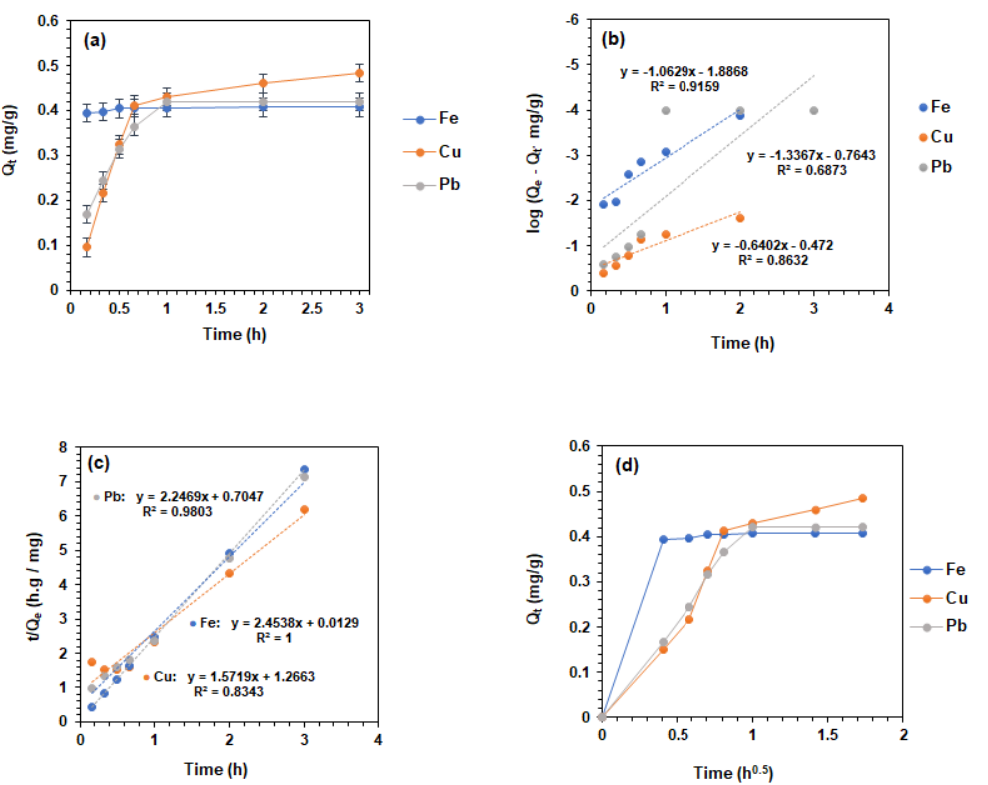
Figure 4. ( a ) The effect of time on the adsorption capacity Fe 2+ , Cu 2+ , and Pb 2+ by MXM . ( b ) PFO kinetic model on the adsorption capacity Fe 2+ , Cu 2+ , and Pb 2+ by MXM . ( c ) PSO kinetic model on the adsorption capacity Fe 2+ , Cu 2+ , and Pb 2+ by MXM . ( d ) Intraparticle diffusion model on the adsorption capacity Fe 2+ , Cu 2+ , and Pb 2+ by MXM .